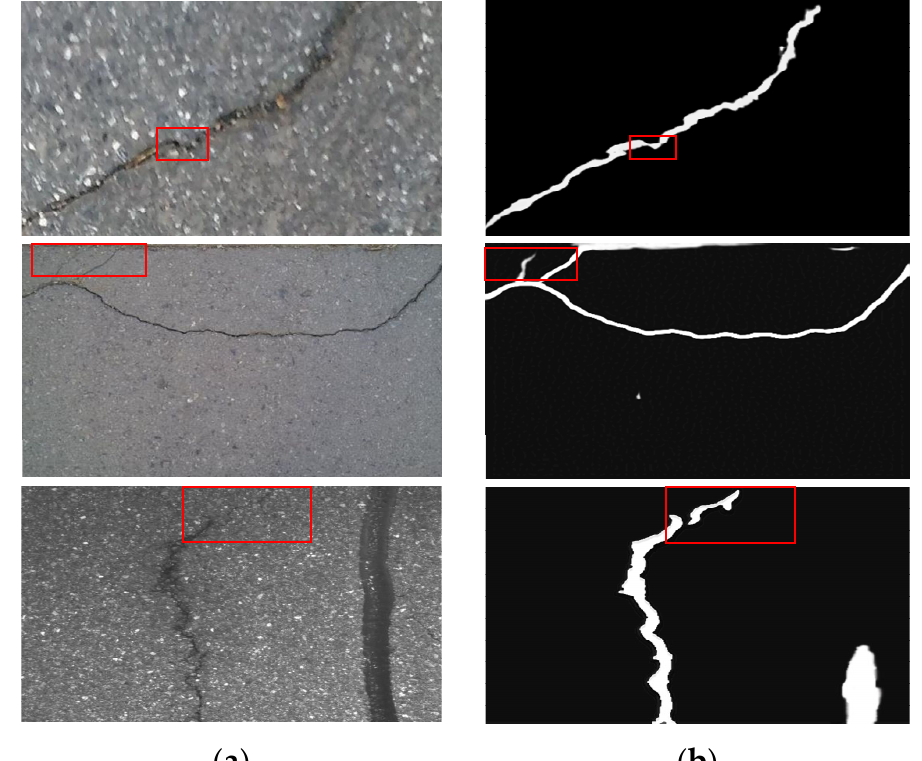
Figure 10. Detail region of crack segmentation results: ( a ) original images; ( b ) segmentation images. When the lighting conditions change during the shooting of the crack image, different parts of the same crack may show different colors and brightness values, making the target visually easily misclassified as different objects. Under polarized light, the target discrimination of the depth features extracted by U-Net network would become worse, which inevitably leads to the decline in target segmentation performance. In addition, the bias-light phenomenon also brings some challenges to manual labeling. In order to further verify the good crack segmentation performance of the proposed method in the case of bias-light, three crack images with an obvious light change, a shadow change and under low illumination were selected, respectively, for comparison experiments. Figure 11 shows the original crack images and the segmented cracks by FCN [40], RCF [41], HED [11], FPHBN [12], DAUNet [18], SPLAC U-Net [23] and our method, respectively. As shown in Figure 11, the segmentation results of FCN [40], RCF [41] and HED [11] involved a lot of noise pollution, resulting in poor segmentation performance. Compared to FCN [40], RCF [41], HED [11] and FPHBN [12], the segmentation performance of DAUNet [18] and SPLAC U-Net [23] was better. However, as shown in the sixth and seventh columns of the second row of Figure 11, cracks could hardly be detected by these two methods under low illumination. Although there were a few false alarms and missed detection, the proposed method still achieved the best crack segmentation performance under a variety of conditions. The excellent performance benefitted from the use of white